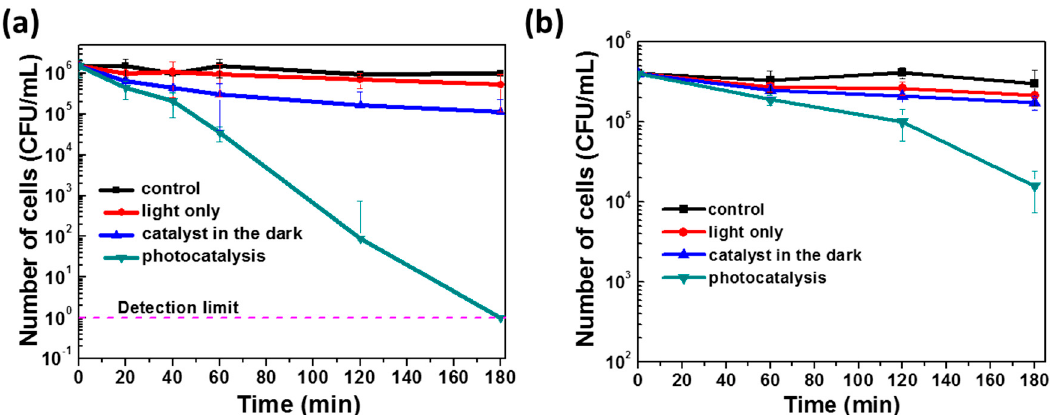
Figure 4. Loss of cultivability of E. coli MG1655 (colony forming units) during photocatalysis using ( a ) dispersed and ( b ) immobilized ZnO NRs. “Control” represents a light-free, ZnO-free condition, while “light only” corresponds to light-exposed cells in the absence of the photocatalyst.